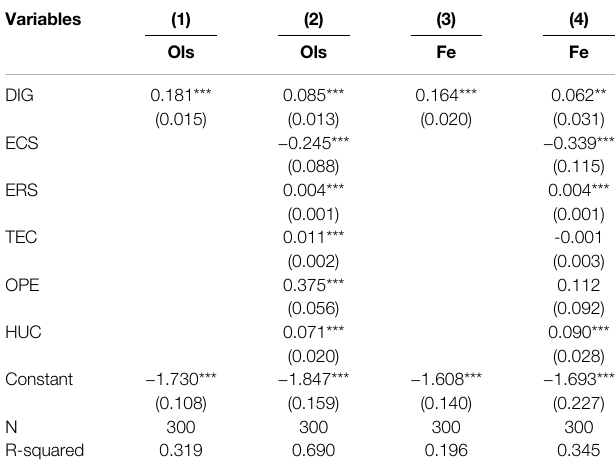
TABLE 3 | Baseline regression